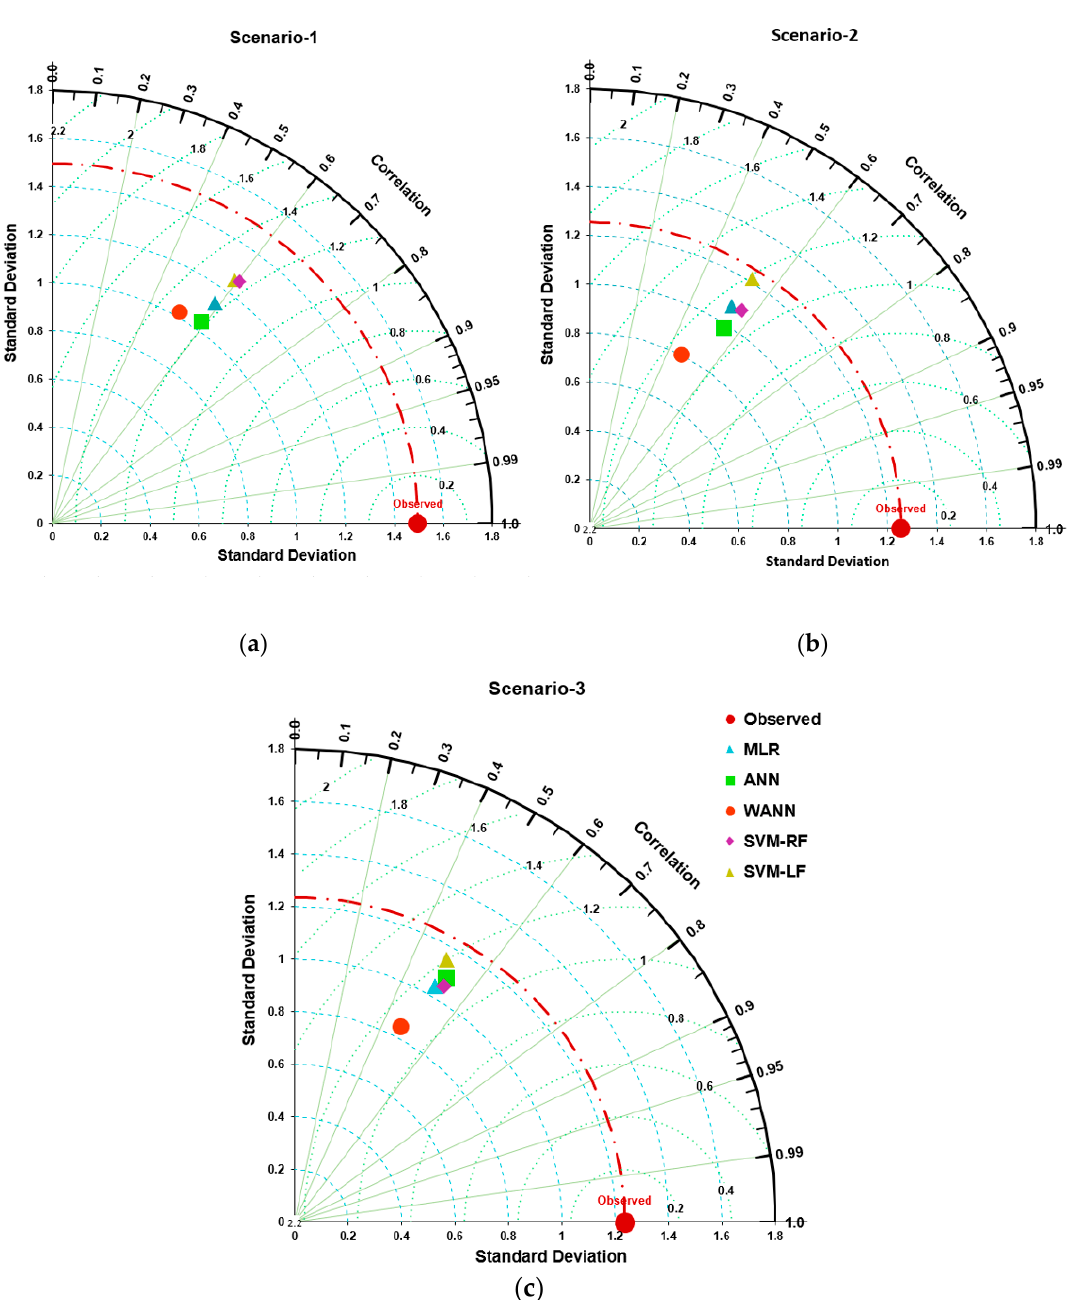
Figure 9. Taylor diagrams of ANN, WANN, SVM-RF, SVM-LF, and MLR corresponding to ( a ) Scenario 1, ( b ) Scenario 2, ( c ) Scenario 3 during the testing period at the study site.